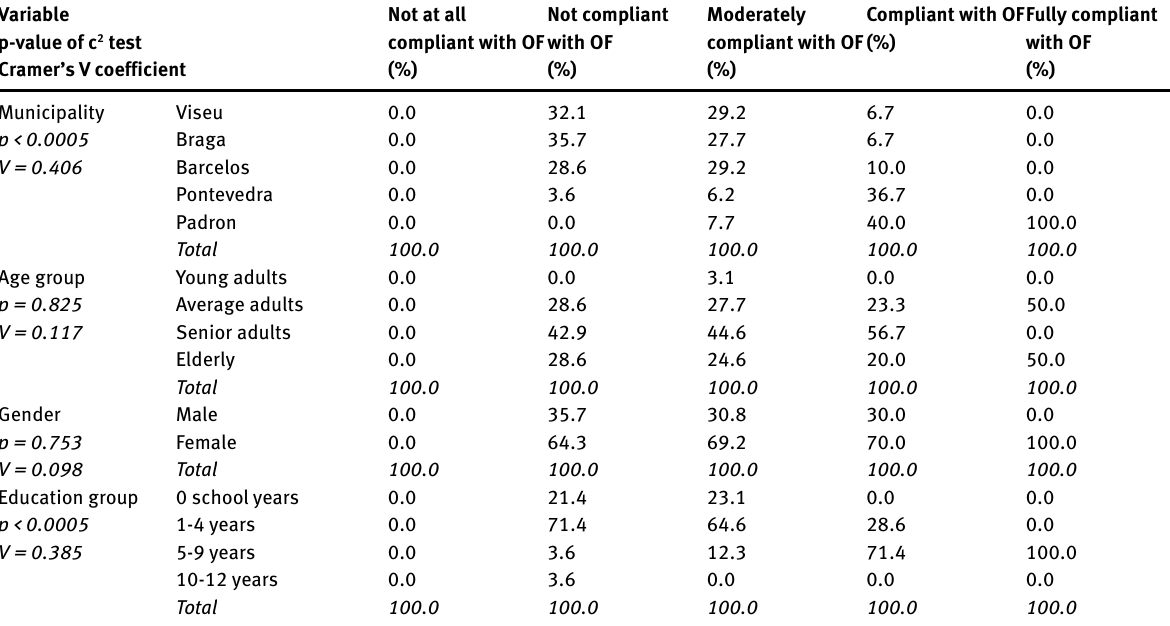
Table 4: Associations between the variable compliance with the practices of OF and the socio-demographic variables Variable p-value of c 2